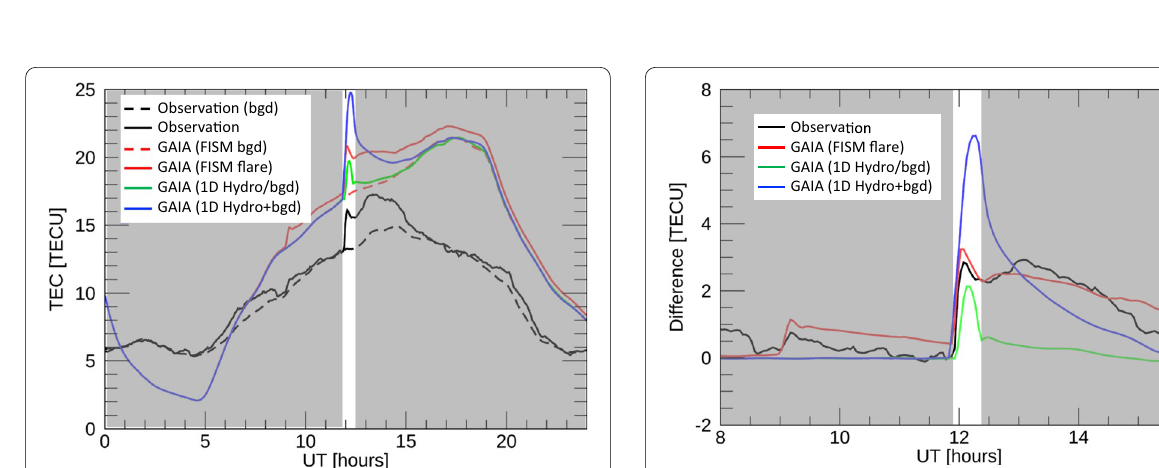
Fig. 10 Difference in TEC from background at 0°E 44°N. The black line is the difference between the observed TEC and the background. The red, green, and blue lines represent the difference in the calculation results of GAIA with “FISM” input, ‘‘1D Hydro/bgd” input, and “1D Hydro bgd” input from the background, respectively. Gray regions + have no 1D Hydro model